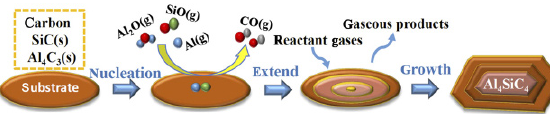
Fig. 7 Schematic illustration of two-dimensional nucleation and growth of Al 4 SiC 4